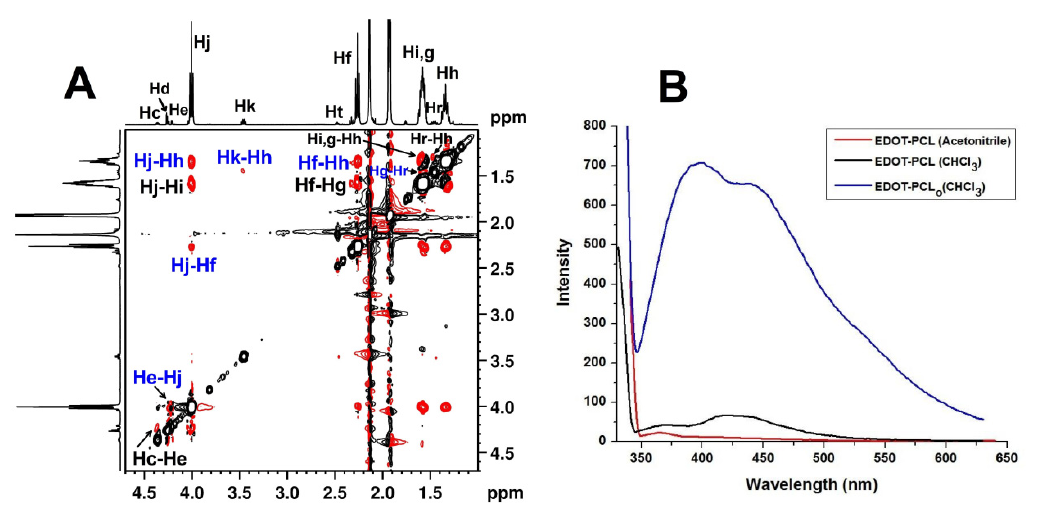
Figure 2. ( A ) 2D NOESY 1 H– 1 H spectrum of EDOT-PCL in CD 3 CN (0–4.7ppm range). ( B ) Fluorescence spectra of EDOT-PCL macromonomer and its oligomerized form ( EDOT-PCL o ) in the used solvents at concentrations of 1 mg/mL, (0.49 × 10 − 6 M), and λ excit = λ max abs (see Table S3).